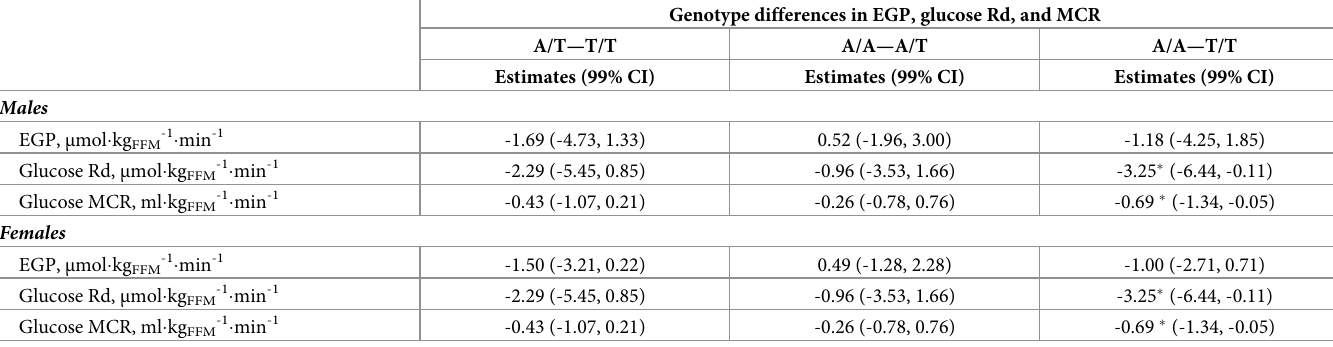
Table 4. Time and genotype differences a in EGP, glucose Rd, and MCR, for males and females as estimated by the LMM